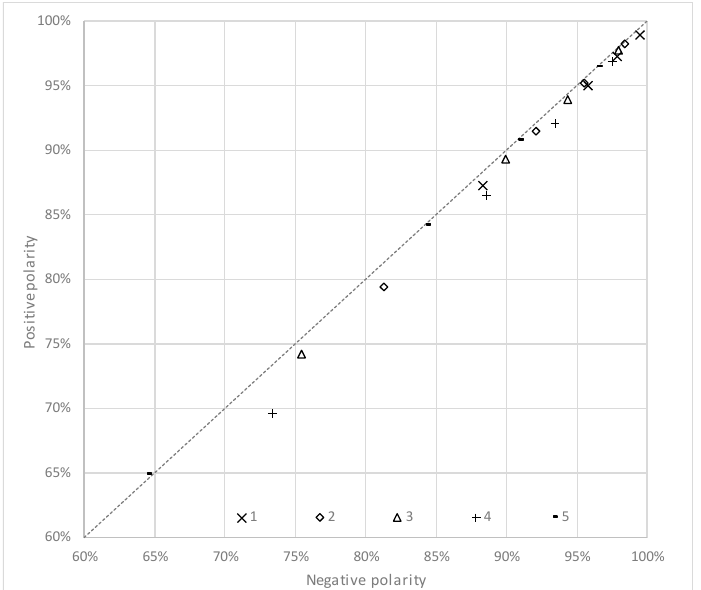
Figure 11. Product PSD after a different number of pulses (feed monosize 3350/2000 µm) and different polarity.